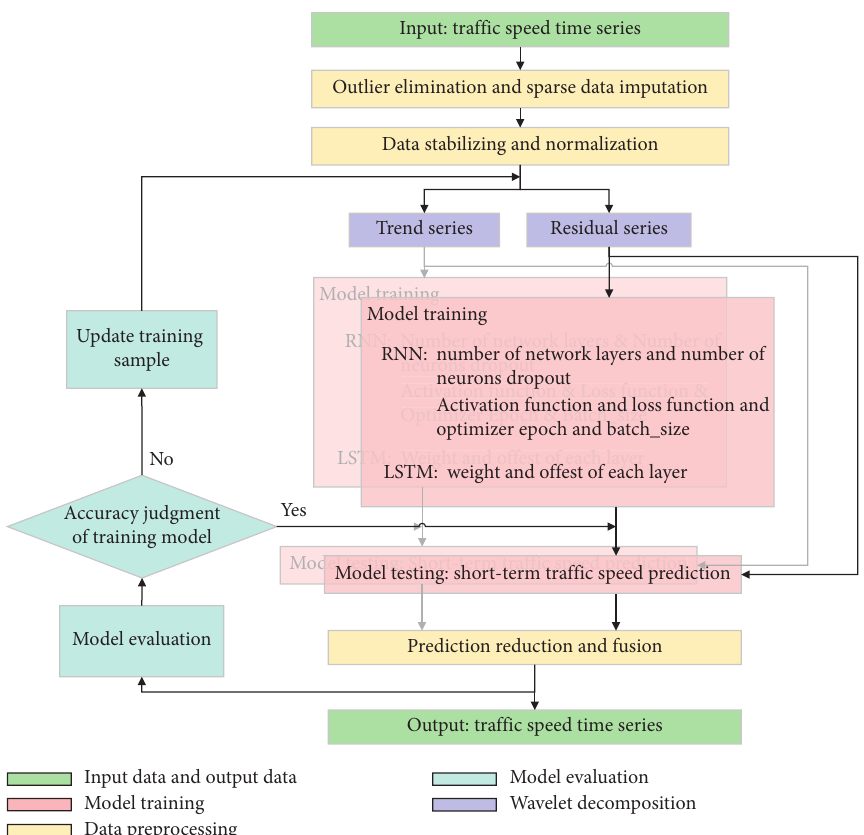
Figure 7: Algorithm flow chart of prediction model for short-term traffic velocity based on LSTM. “Epoch” represents the frequency of the data sample in rounds, and “Batch_size” refers to the optimal sample batch set to obtain a stable precision gradient descent.